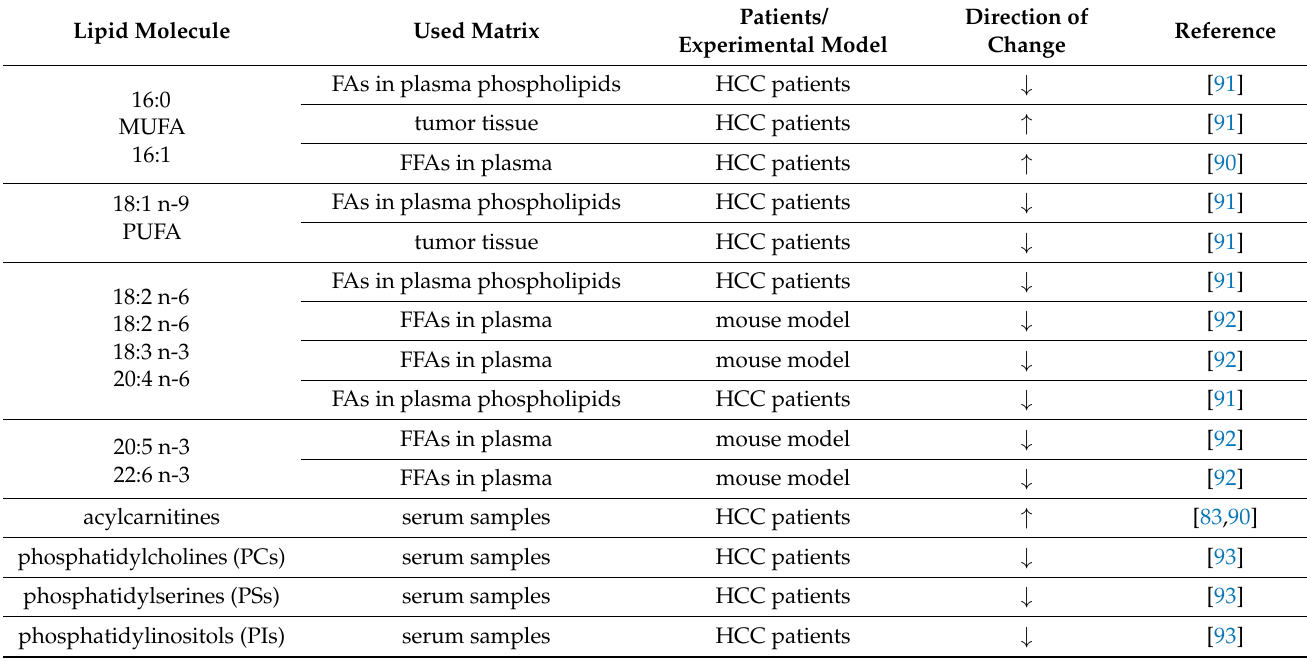
Table 1. Lipid alterations in hepatocellular carcinoma